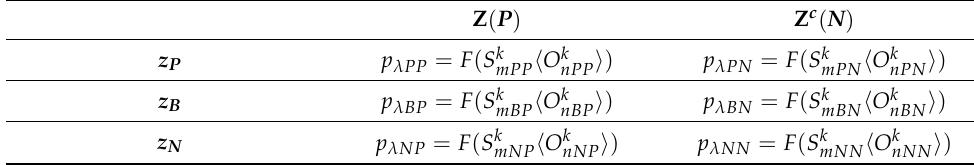
Table 1. The DHHLT loss functions of the actions in different